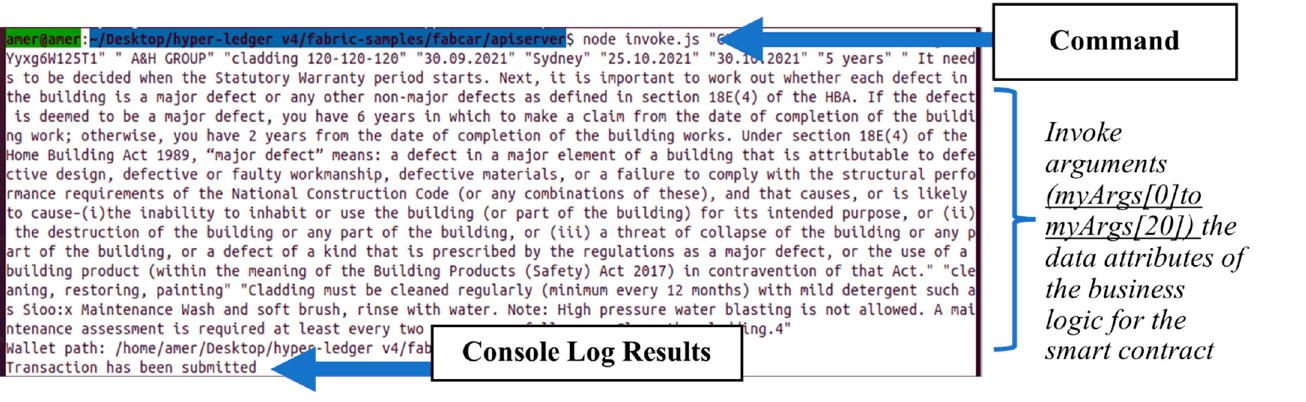
Figure 6. We invoked the application’s arguments, as shown in the Git console.